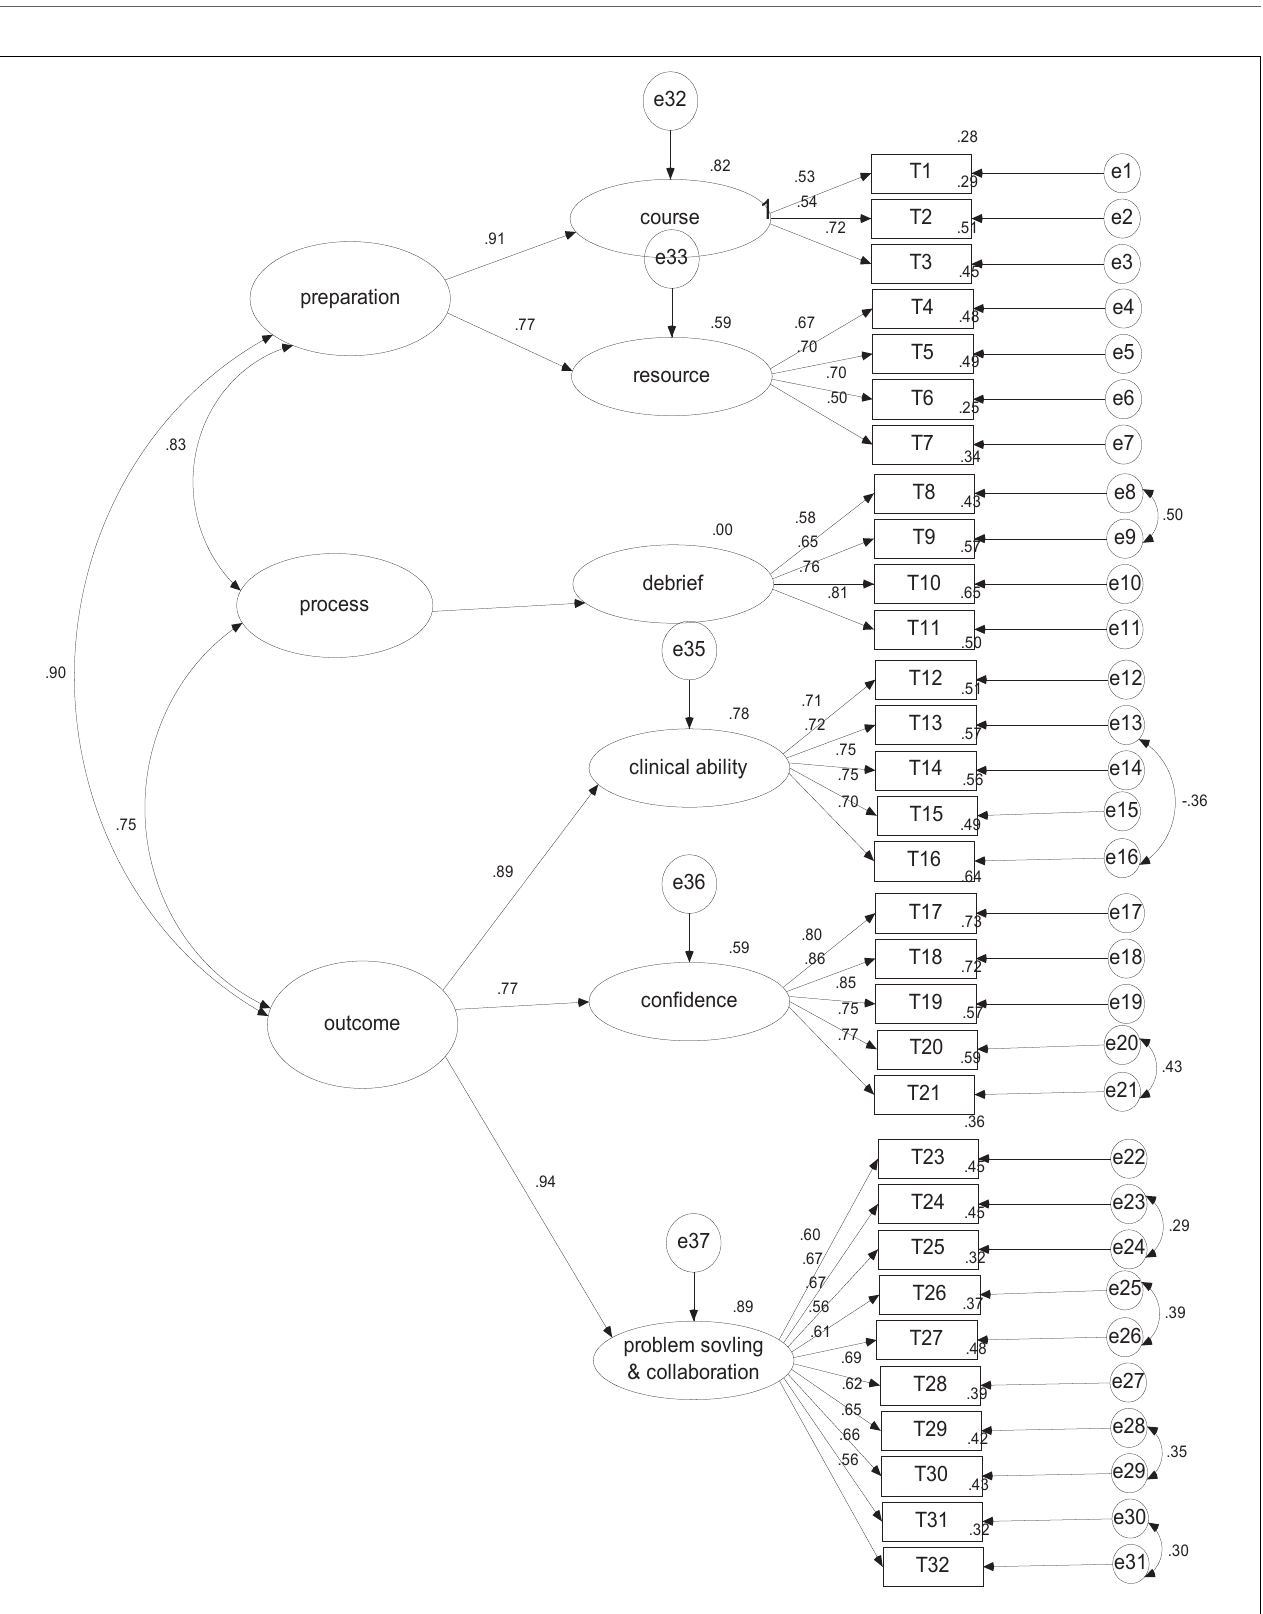
FIGURE 1 | The 6-factor model of the SLEI-SC with standardized estimates ( N = 267). SLEI-SC indicates the simulation learning effectiveness inventory-a simplified Chinese